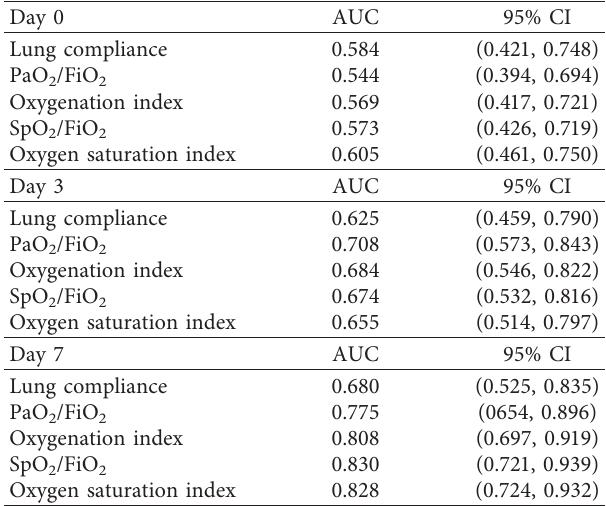
Table 4: Comparison of areas under the receiver operating characteristic curve for discrimination of hospital